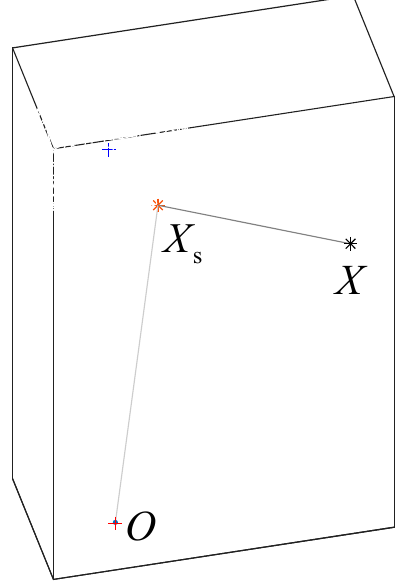
Figure 1. Reflection scheme for a single 3D point.